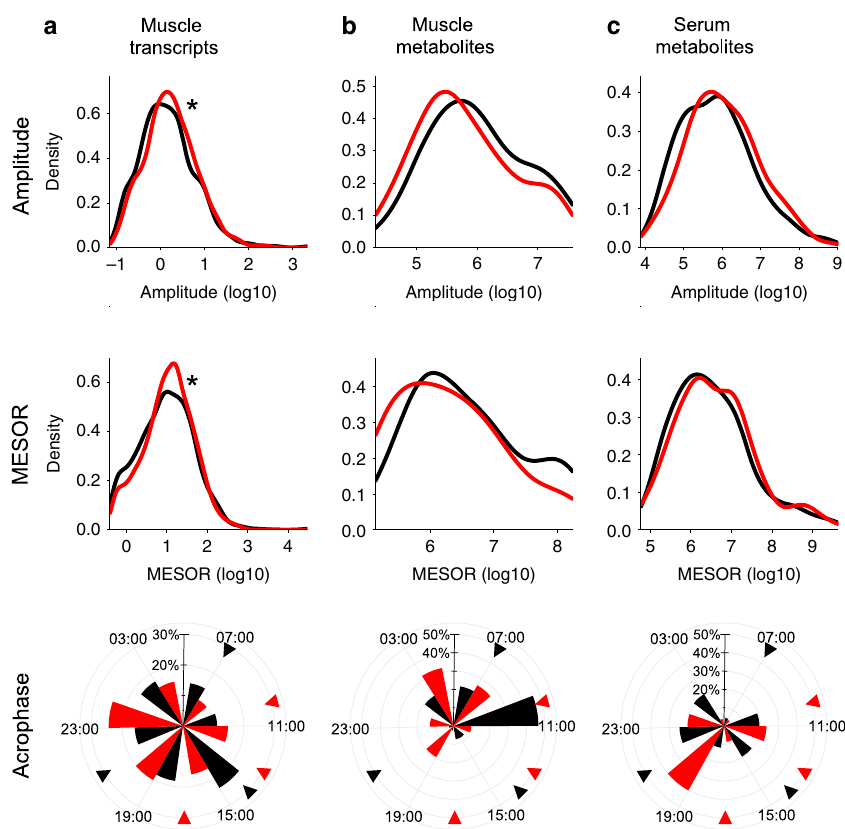
Fig. 3 Amplitude and peak distribution of periodic features. Density plots of signi fi cantly periodic features in each respective condition, showing amplitude, MESOR and acrophase with black line representing extended feeding (EXF), and red line representing time-restricted feeding (TRF), for skeletal muscle transcripts ( a ), skeletal muscle metabolites (p mesor = 0.0018, and p amplitude = 0.0006) ( b ), and serum metabolites ( c ). Triangle indicates feeding time. * p < 0.05 Kolmogorov – Smirnov two sample and two sided test for EXF versus TRF, n = 11